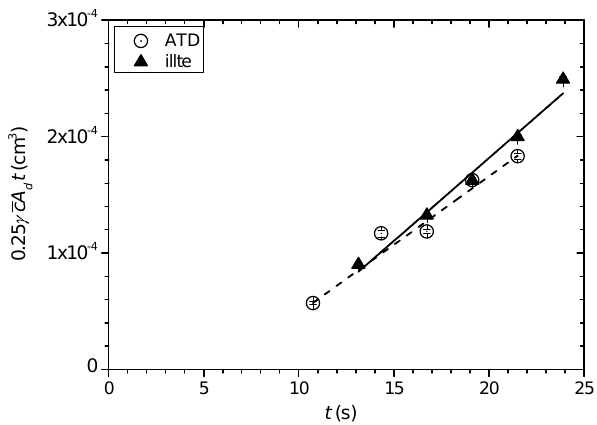
Fig. 5. Plot of 0 . 25 γ exp ¯ cA d t , versus the contact time ( t) for N 2 O 5 with dust aerosols in the AFT. The lines are least-squares fits to the illite (solid line) and ATD (dashed line) data sets. The error bars are statistical (2 σ)